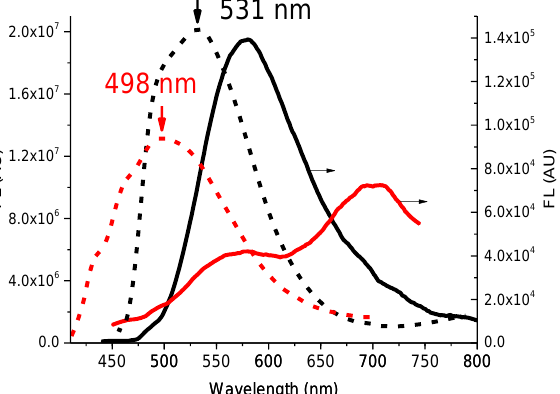
Figure 4. Emission spectra of 10 µ M methanol solution of 5 (black) and 6 (red) at room temperature (20 ◦ C, solid line) and in liquid nitrogen ( − 189 ◦ C, broken line).